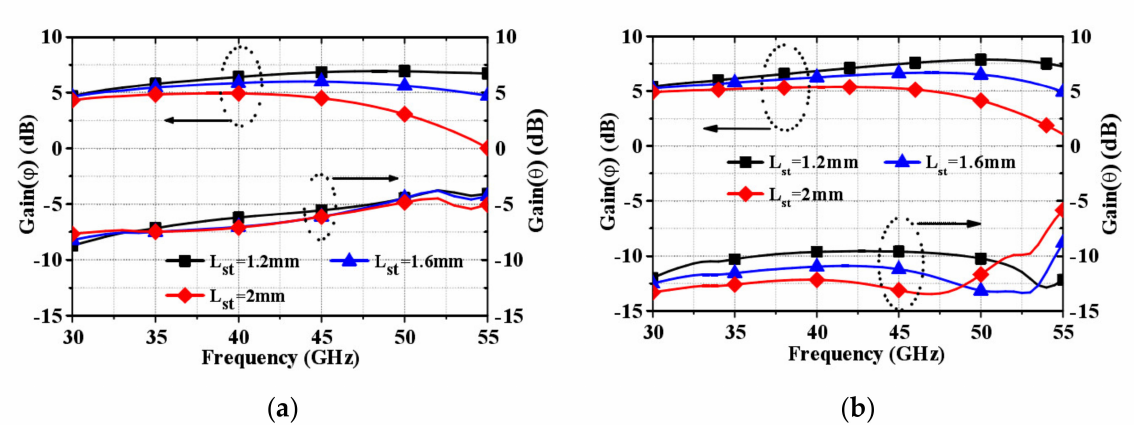
Figure 8. The orthogonal gain components (Gain( θ ) and Gain( ϕ )) of Antenna A and our proposed Antenna B; ( a ) Antenna A with different L st . ( b ) Antenna B with different L st .